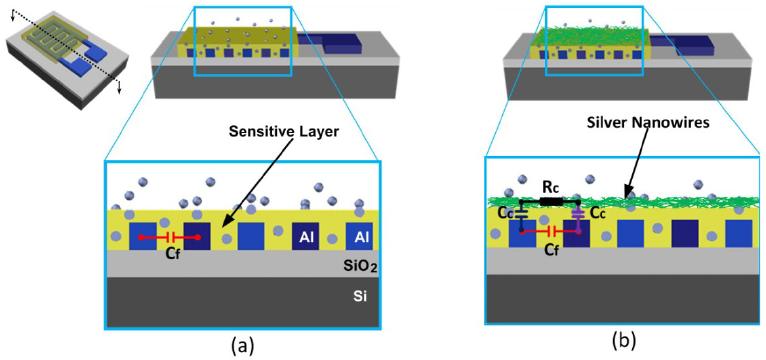
Figure 1. Sketch of an interdigitated capacitive humidity sensor: ( a ) conventional structure; ( b ) capacitive coupling structure.